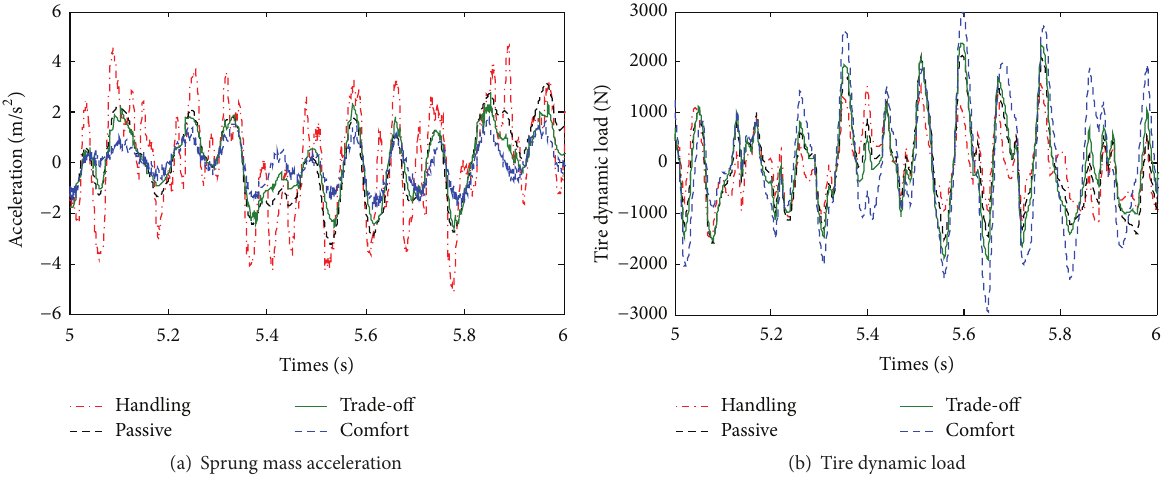
Figure 9: Actual responses of the proposed suspension comparing to passive suspension.